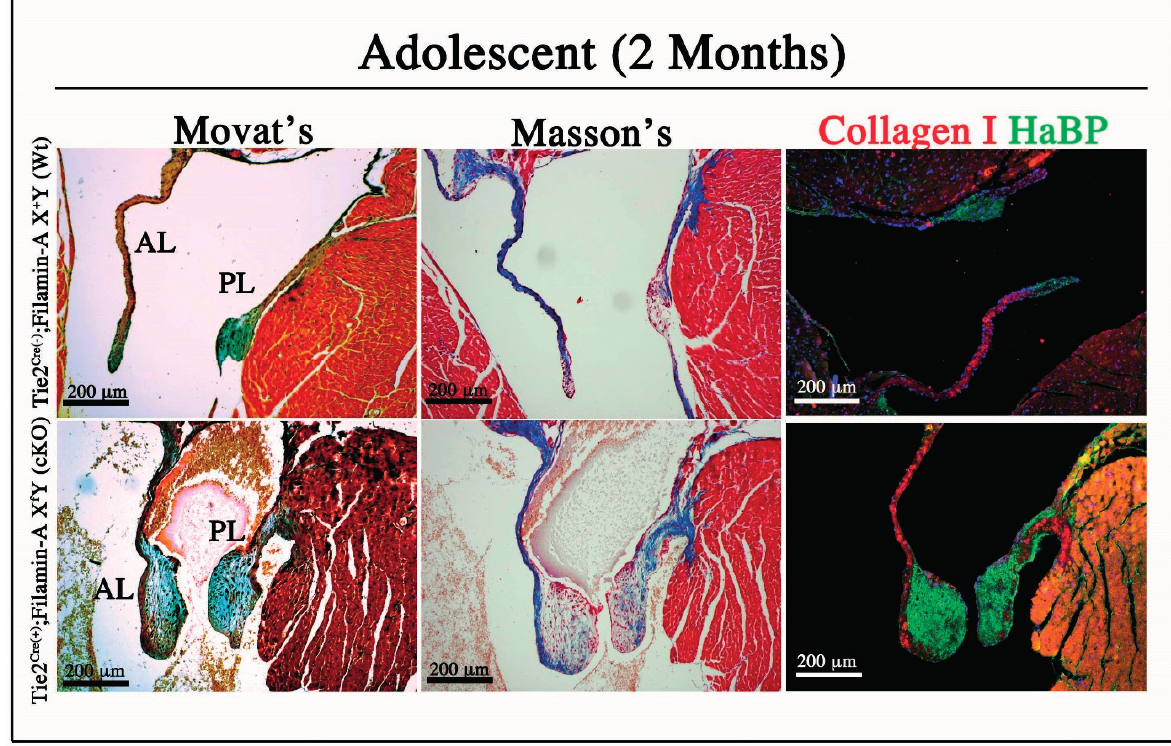
Figure 1. Filamin-A-deficient Mice Exhibit Myxomatous Mitral Leaflets. Adolescent 2-month-old mice were analyzed by Movat’s Pentachrome, Masson’s Trichrome, and Immunofluorescence for Collagen I ( red ) and Hyaluronan-binding protein (HaBP) ( green ). Movat’s: Collagen ( yellow ), proteoglycans ( blue ), elastin/nuclei ( black ), muscle (red). Masson’s: Collagen (blue), nuclei (black), muscle (red). Filamin-A-deficient mice exhibit increased proteoglycan content and disrupted matrix organization characteristic of myxomatous